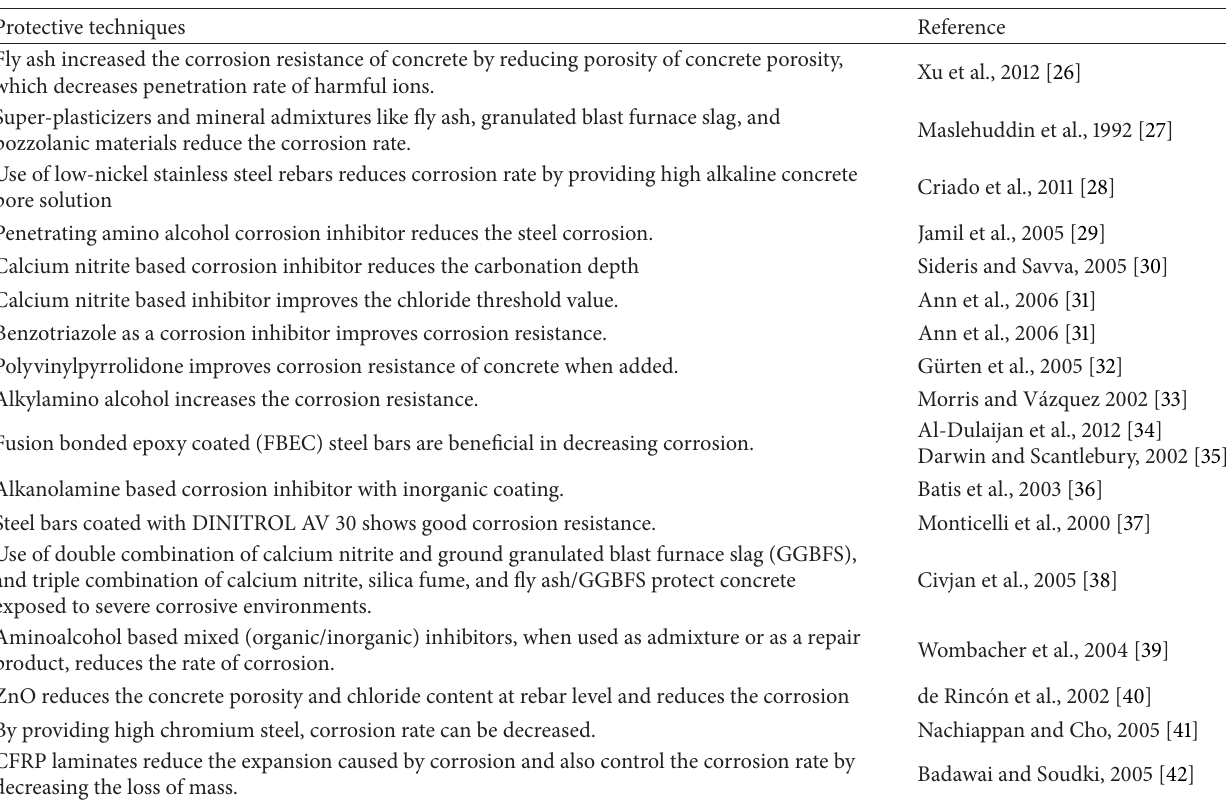
Table 4: Techniques to protect concrete from